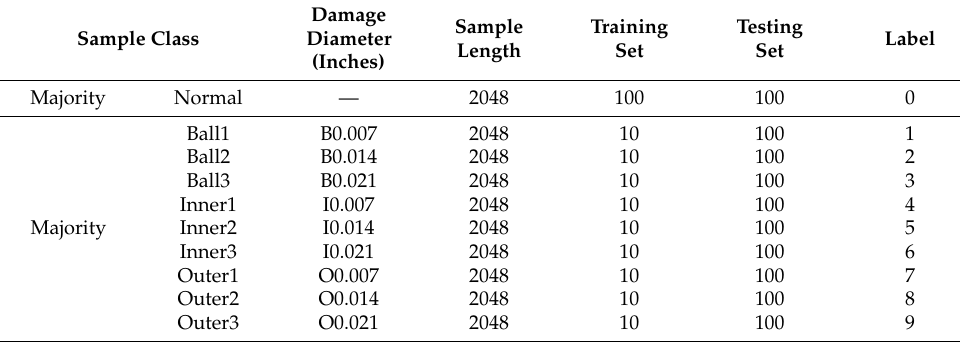
Table 4. The details of the bearing dataset.